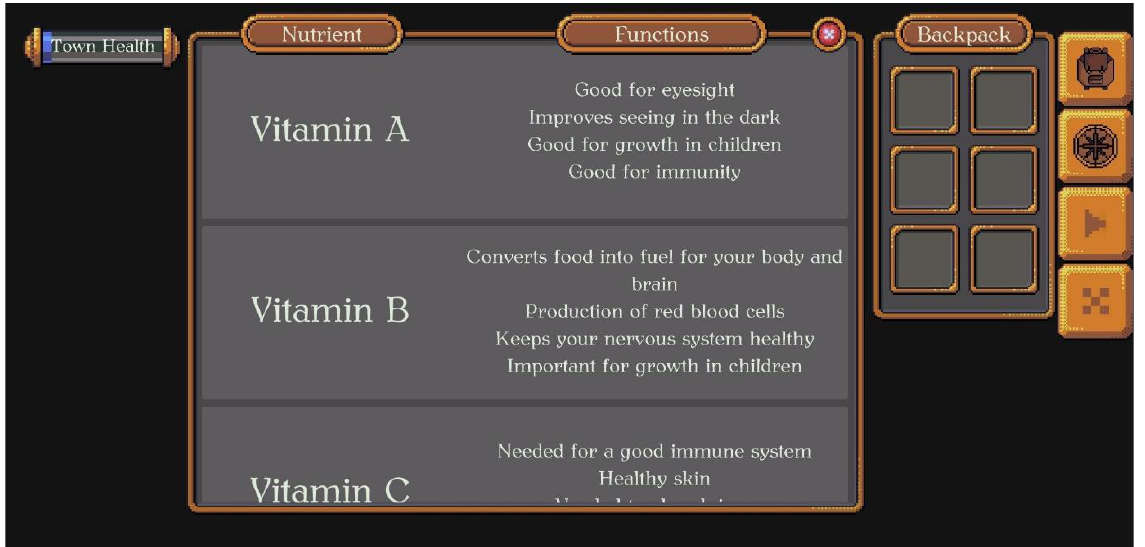
Figure 3. After choosing a nutrient in the shop list, the player can choose to ‘buy’ seeds for the foods that need to be grown, or information appears on where they have to go to acquire the food (e.g., milk is the product under ‘calcium’, for which the player has to milk the cow at their farm.